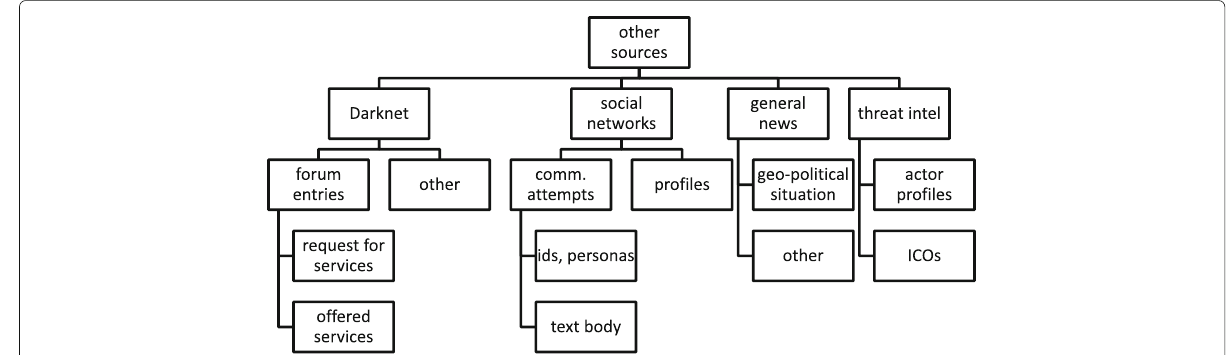
Fig. 5 Types of artifacts gathered from other sources (than technical infrastructures) that aid the attribution process